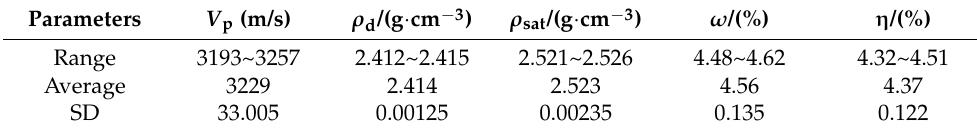
Table 1. The physical parameters of the selected samples.